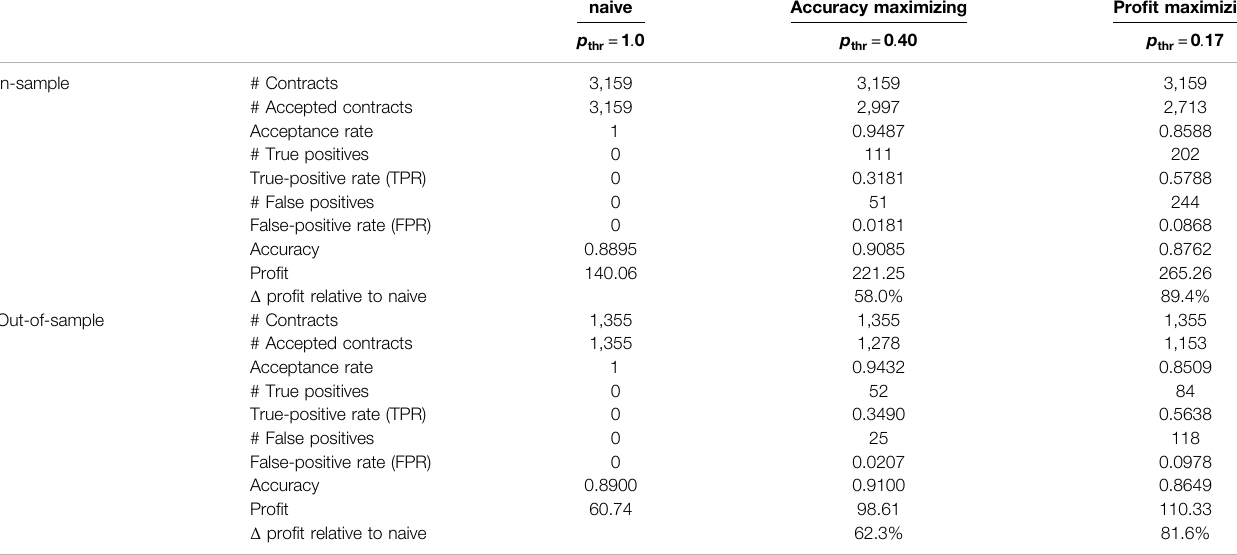
TABLE 3 | Overview of the in- and out-of-sample performance fi gures of logistic regression models with different thresholds p thr . naive Accuracy maximizing